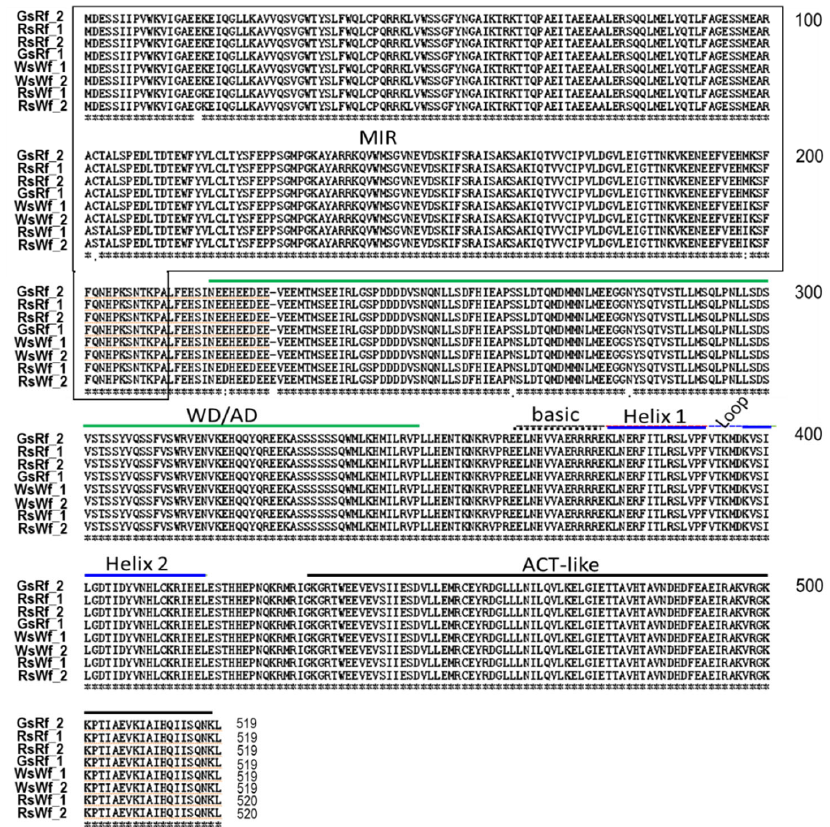
Figure 5. Alignment of amino acids of RsTT8 from four radishes used in this study. MIR (MYB ‐ interacting domain), WD/AD (WDR interacting region through the acidic domain), bHLH region, and ACT ‐ like domain were well conserved among RsTT8s, indicating that resulting proteins keep their activity. Regulation may depend on the expression level. Numbers on the right denoted the number of amino acid residues.